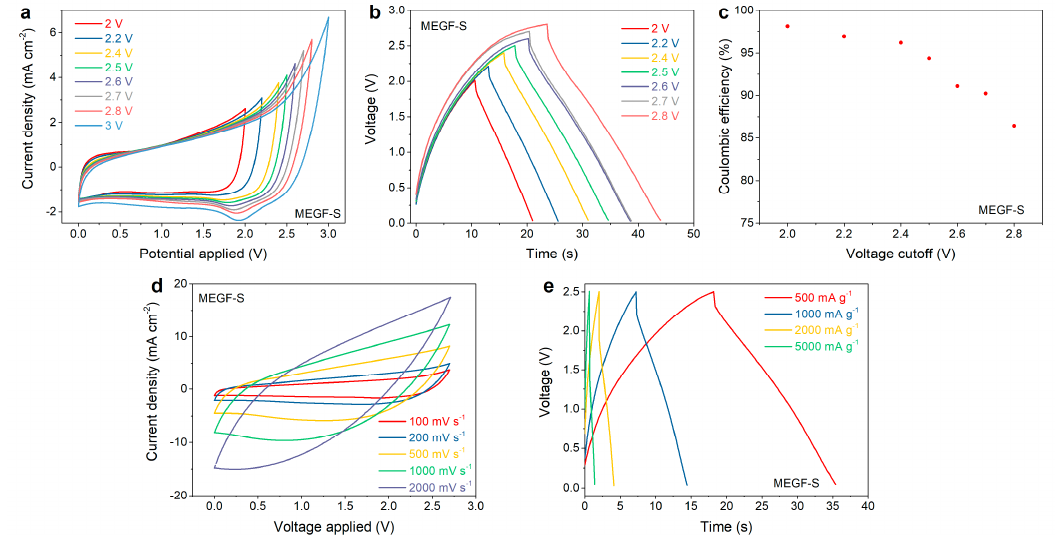
Figure 5. Electrochemical data for MEGF-S: cyclic voltammograms with increasing upper vertex voltages ( a ), Galvanostatic charge–discharge curves with increasing upper voltage cut-off ( b ) and relative Coulombic efficiencies ( c ), cyclic voltammograms at increasing scan rates ( d ), and galvanostatic charge–discharge curves at increasing current densities ( e ).